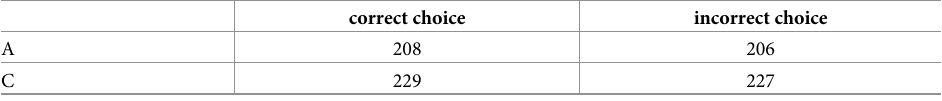
Table 5. Number of times an annotator has opted for annotation value A vs C, distinguishing between correct and incorrect choice. C is preferred over